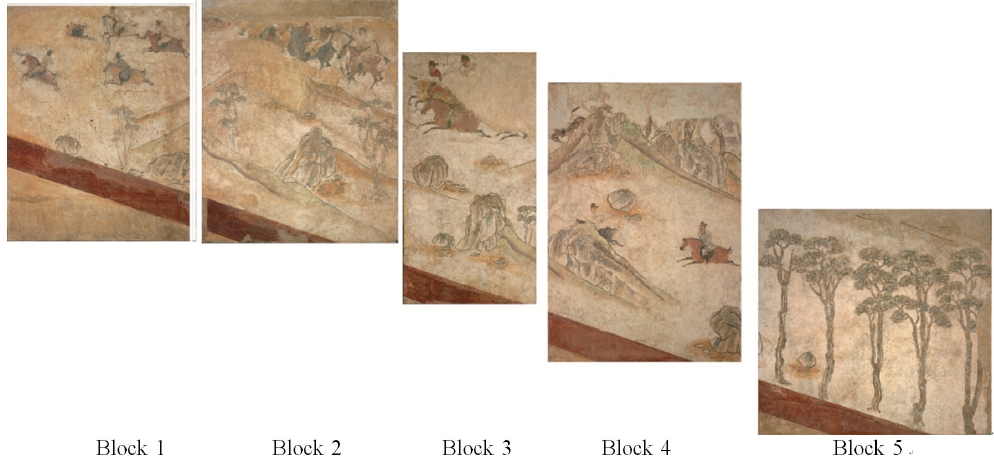
Fig. 1 Blocks of the tomb mural in Zhanghuai‘s